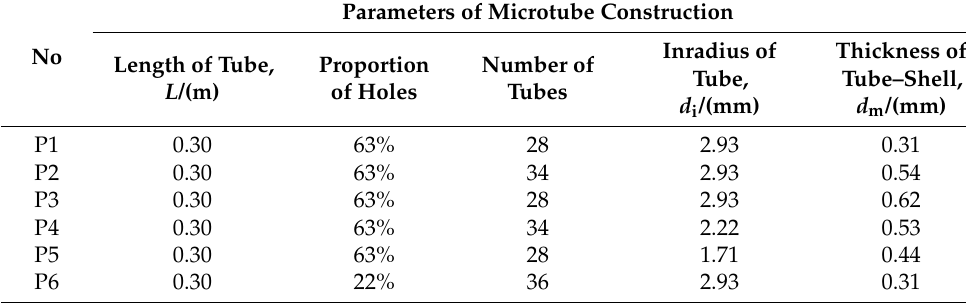
Table 2. Parameters of microtube module construction.